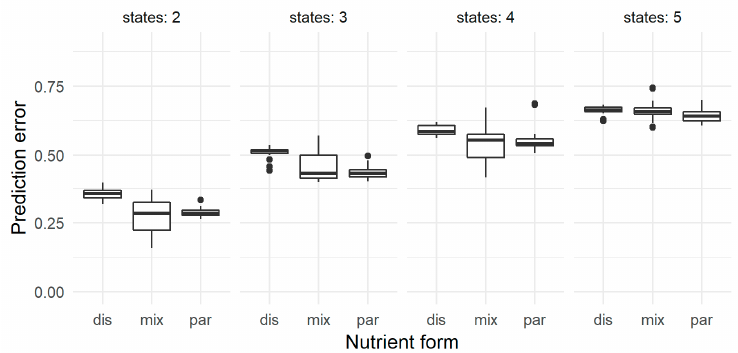
Figure 7. Cross-validation results for disaggregated (dis), particulate (par), and mixed (total, mix) nutrients and different numbers of output states. Table 3. Effect of the state number of parent nodes on prediction errors for different BNs. Mean errors and p values based on the outcomes of six BNs (RBZ width, RBZ slope) and nine BNs (soil texture). The nodes “flow pathway” and “RBZ vegetation” in complete BNs have only two states and are not shown.